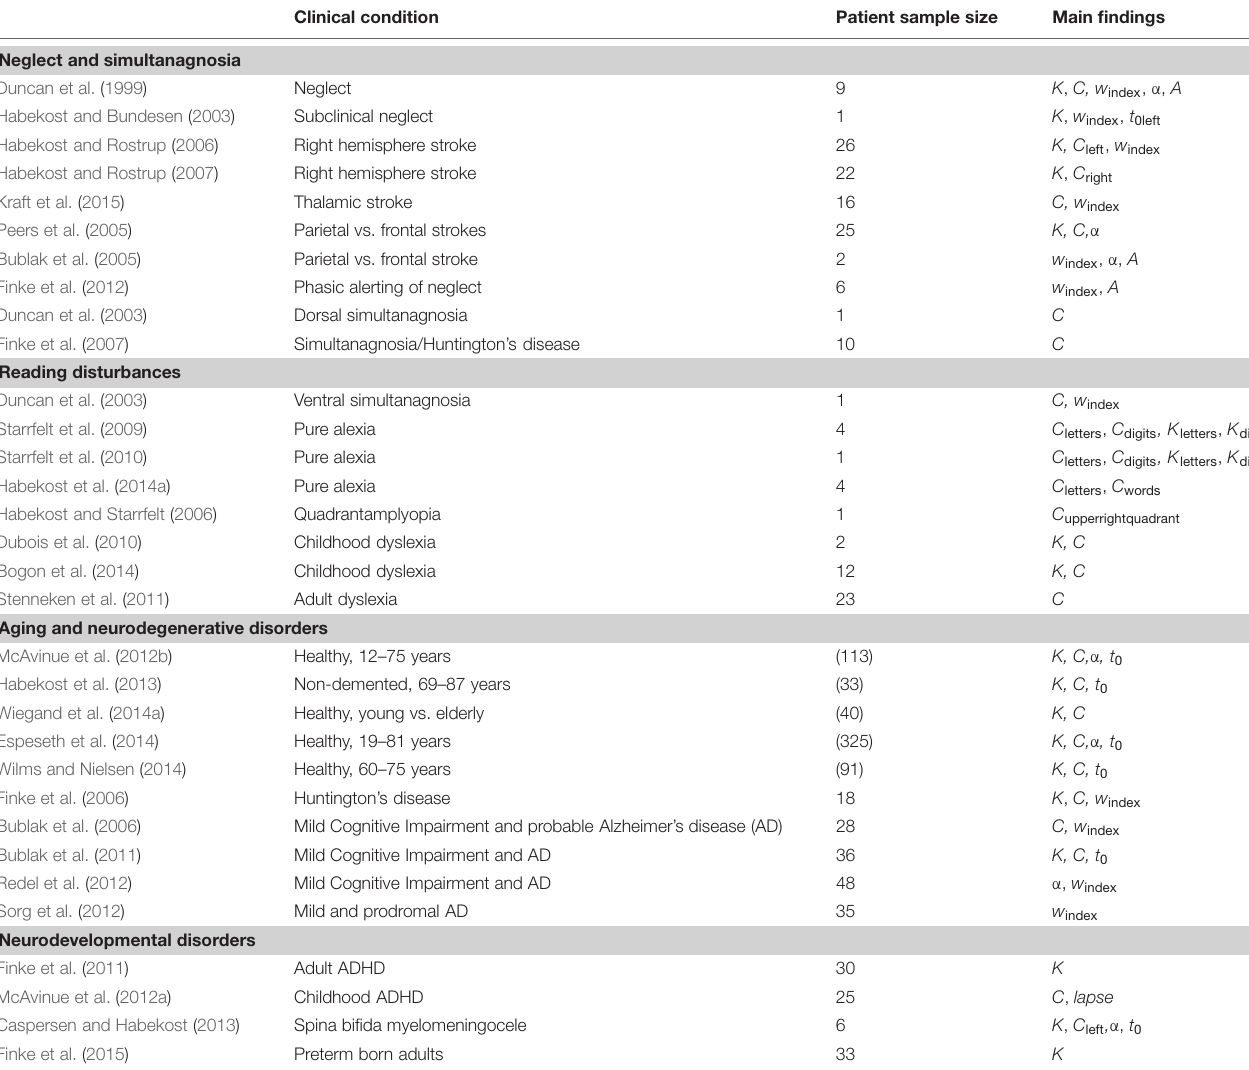
TABLE 1 | Clinical theory of visual attention (TVA)-based